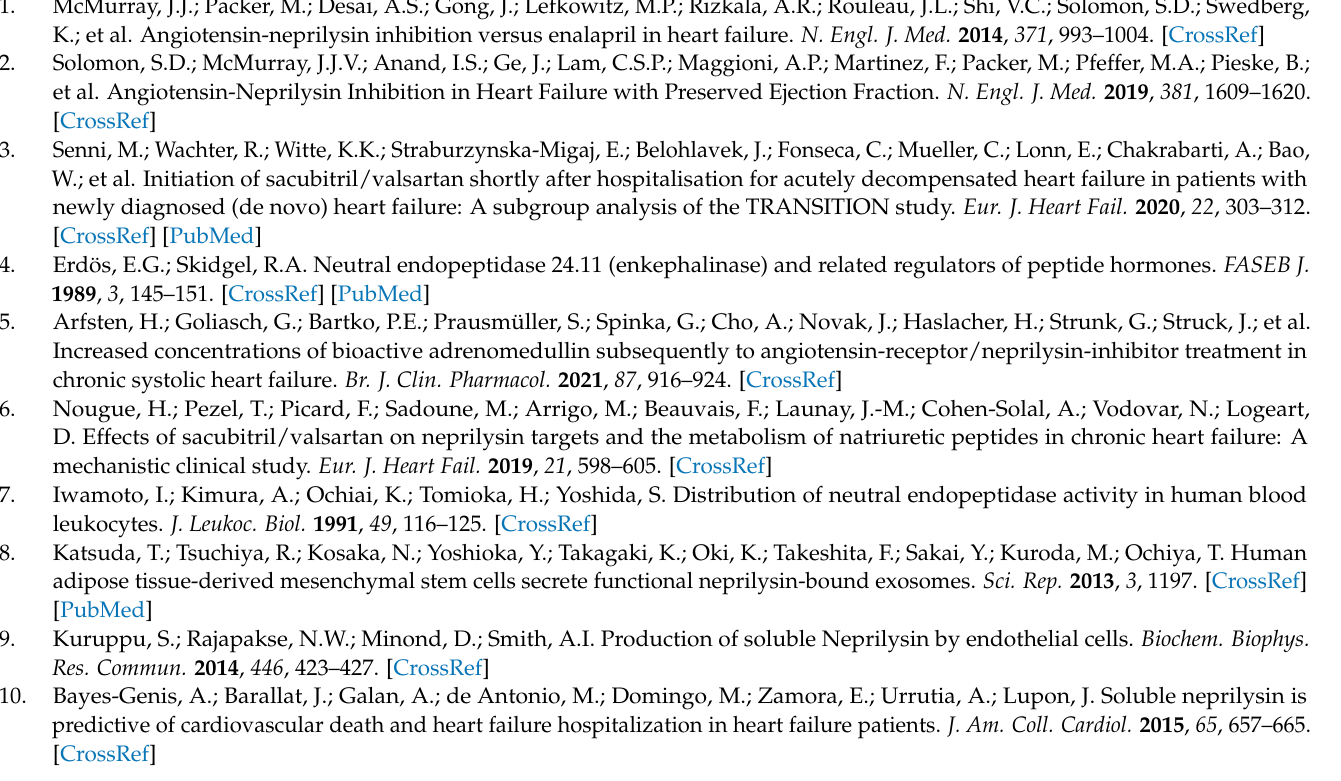
HFrEF patients. Table S1: Baseline characteristics presented for the HFrEF, HFpEF, and control group. Table S2. Baseline characteristics presented for the HFrEF group stratified by heart failure